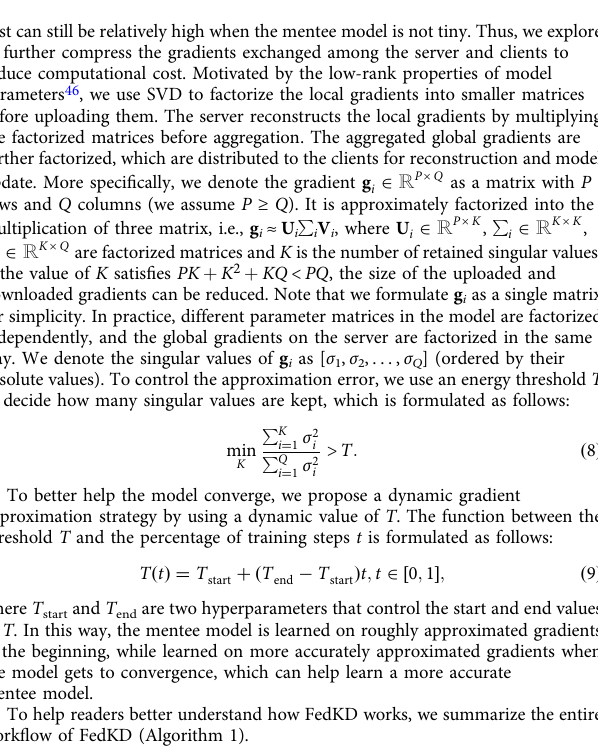
Fig. 5 The framework of our FedKD approach. The local data is used to train the local mentor model and global mentee model. Both models are learned from local labeled data as well as the prediction and hidden results of each other. The local gradients are decomposed before uploading to the server, and then reconstructed on the server for aggregation. The aggregated global gradients are further decomposed and distributed to clients for local